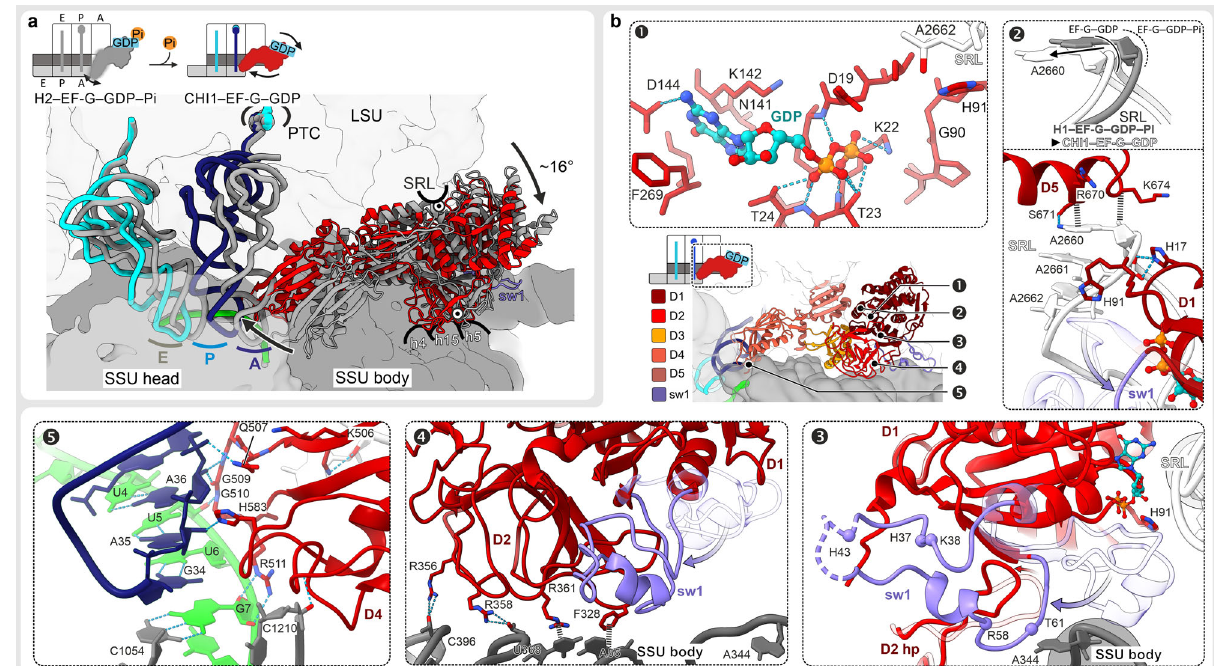
Fig. 4 Large-scale rearrangements triggered by Pi release from EF-G. a Rearrangements of EF-G and tRNAs from H2 (gray) to CHI1 state (colored); SSU domains and LSU are only shown for CHI1. Hinge points of rotation are indicated as white circles with a black dot. b Structure of EF-G – GDP in CHI1 and refolding of sw1 upon Pi release. For comparison, parts of EF-G – GDP – Pi in H1 state, aligned to EF-G D1, are included in semitransparent. Center: overview illustrating the regions shown in panels 1 – 5. Panel 1: nucleotide-binding pocket of EF-G – GDP on the ribosome with substantially fewer interactions as compared to the GDP – Pi state. Panel 2: sw1 loses interactions with the SRL resulting in relaxation of the SRL into its ground state conformation. Repositioning of EF-G also releases the interaction of sw2, i.e., H91, with the SRL. Panel 3: refolding of sw1 upon Pi release obliterates the connection that stabilized the rotated state, which results in the back-rotation of the SSU body. A hairpin (hp) structure of EF-G D2 changes with sw1 and stabilizes the refolded sw1. Panel 4: EF-G D2 forms new contacts with the SSU body domain in a non-rotated conformation. Panel 5: EF-G D4 forms multiple contacts with the SSU head domain and the mRNA – tRNA complex in the decoding center that stabilize SSU head swiveling and chimeric tRNAs